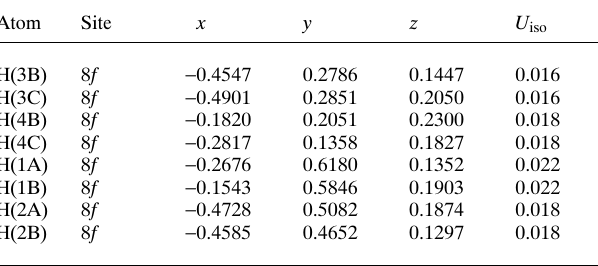
Table 2. Atomic coordinates and displacement parameters (in Å 2 )